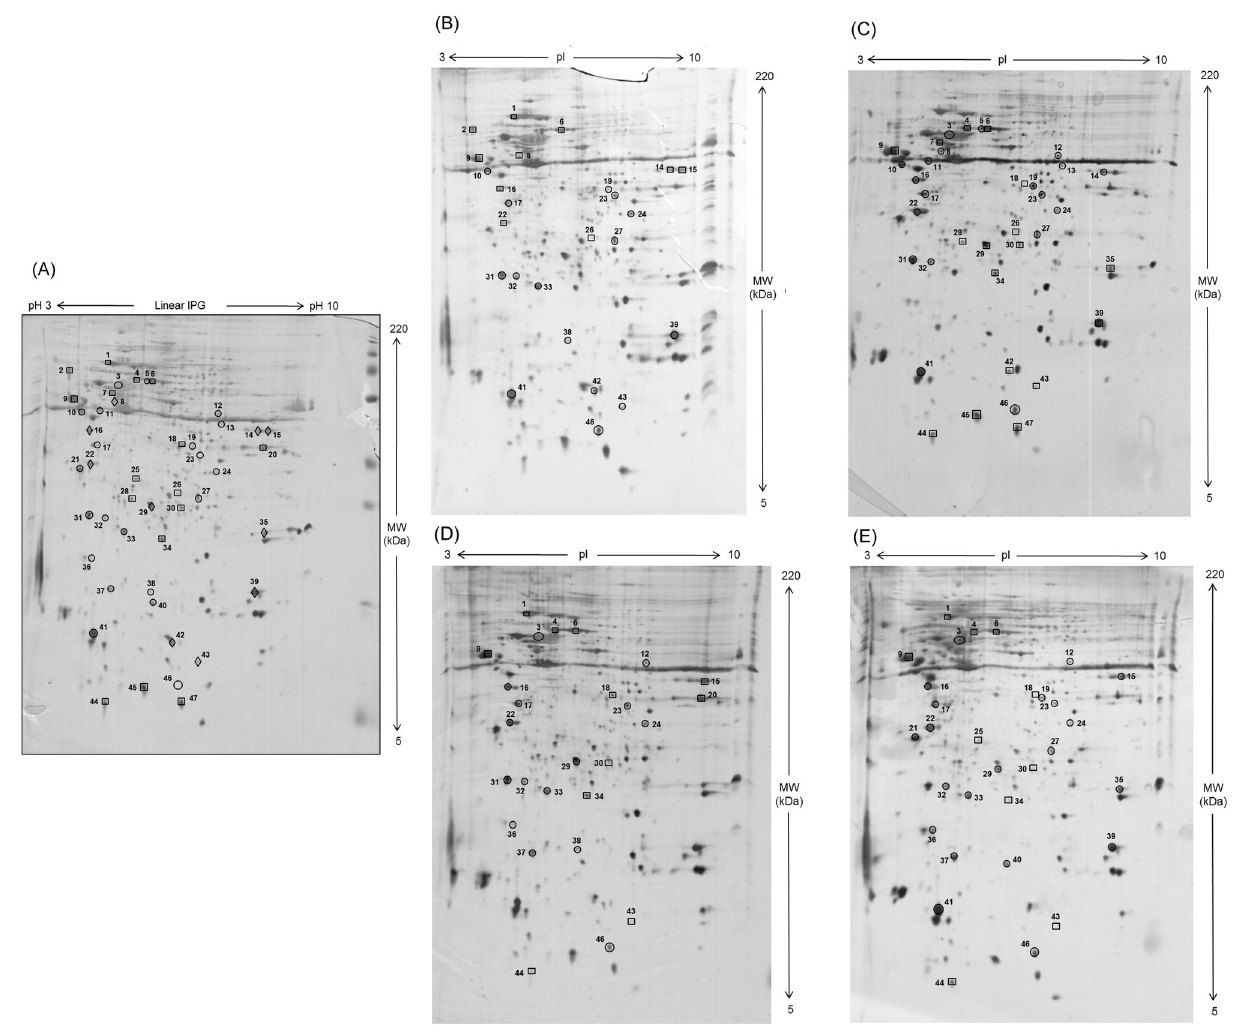
Figure 1. 2-DE protein profile of cardiomyocytes treated with SF. IEF performed on IPG strips (13 cm, 3-10 linear pH gradient) was followed by second dimension separation on a 15% polyacrylamide gel. 2-DE gel was silver-stained. Identified spots, showing a statistically significant difference of at least 1.5-fold between SF-treated cardiomyocytes at different time points [1 (B), 6 (C), 24 (D) and 48 (E) h] and vehicle control (A), are numbered (Table S1). Circles and squares indicate up- and down-regulated protein spots, respectively. (A) Diamonds indicate protein spots with opposite trends of expression among the time points of exposure to SF. doi: